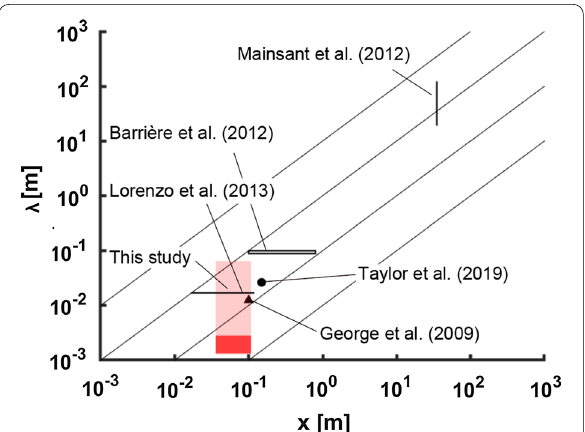
Fig. 1 Parameter space between wavelength (cid:31) and sensor intervals x . We used a velocity at a condition of dry or lower degree of water saturation or velocity profiles in situ (Mainsant et al. 2012) together with frequency of input signals or analyzed frequency, when we calculated (cid:31) . The velocities by George et al. (2009), Barrière et al. (2012), Mainsant et al. (2012), Lorenzo et al. (2013), Taylor et al. (2019), and this study were 250 m/s, 160 m/s, 475 m/s, 170 m/s, 264 m/s, and 65 m/s (refer to “Monitoring capability for water content change in our system” section), respectively. The light red solid rectangle represents our experimental conditions, and the red solid rectangle represents the range that we analyzed in